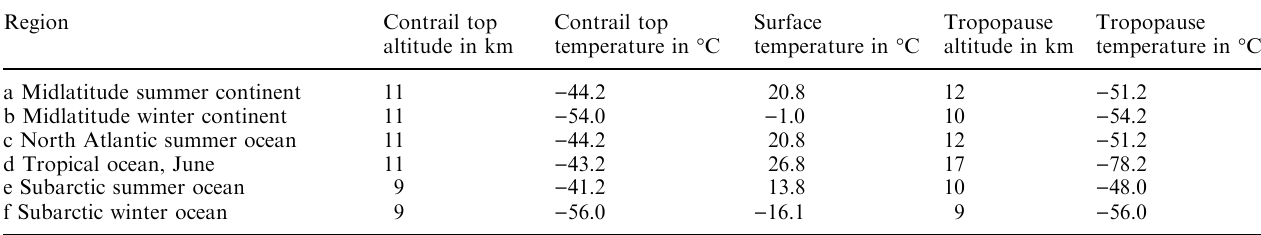
Table 2. Contrail and tropopause altitude and temperature values for cases (a) to (f) Region Contrail top